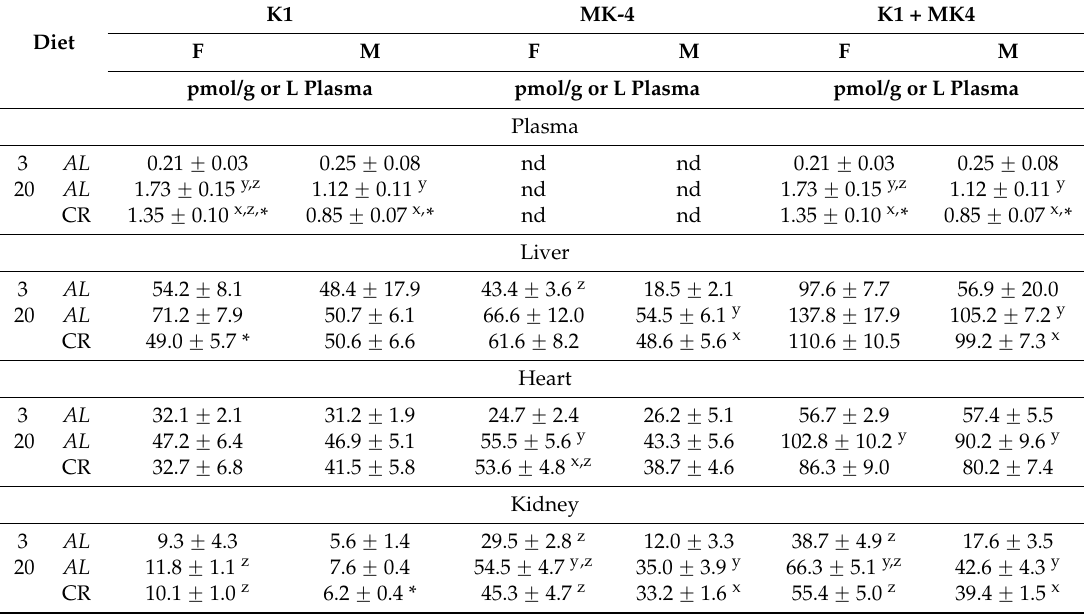
Table 4. Plasma and tissue (the liver, heart, kidneys, spleen, brain, ovaries and testes) K 1 , MK-4 and or CR